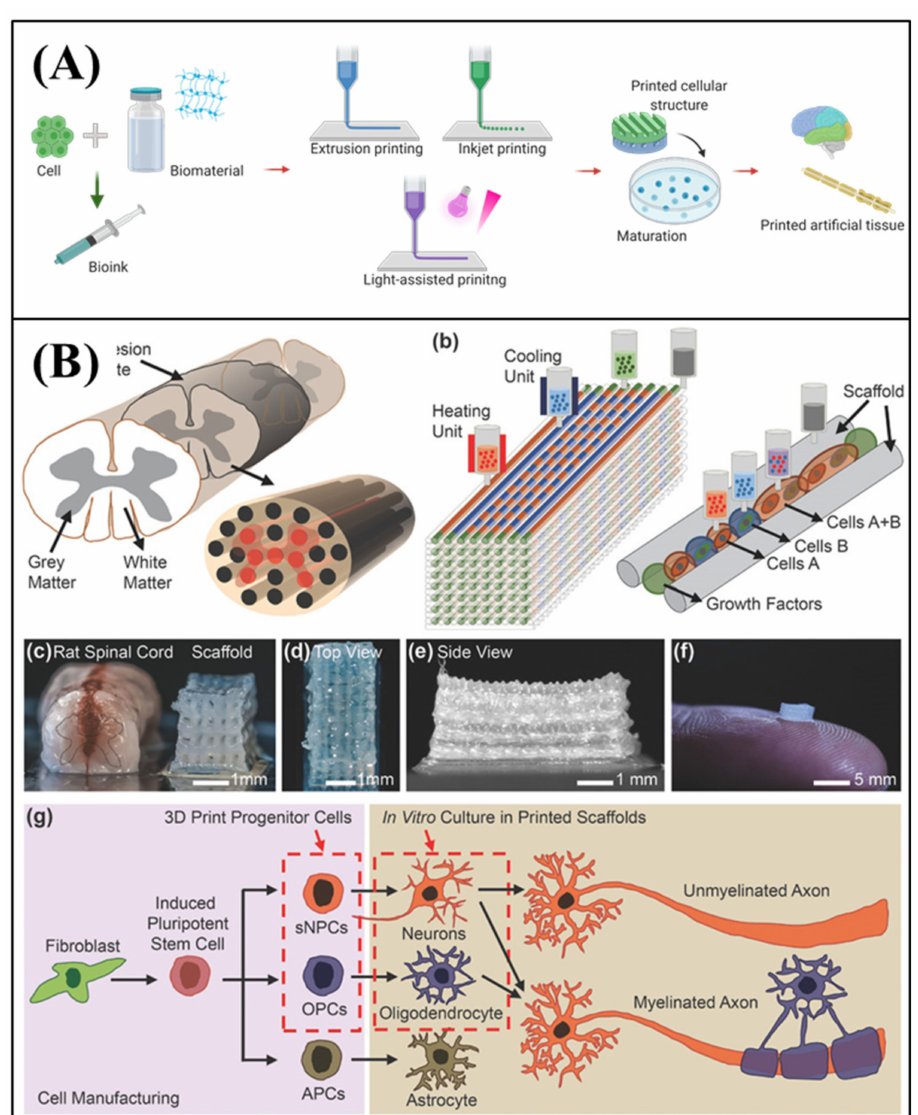
Figure 6. 3D bioprinting based neural MPSs ( A ) Schematic of 3D bioprinting process for neural MPSs. ( B ) 3D cell-printed axon network model. Reproduced with permission from